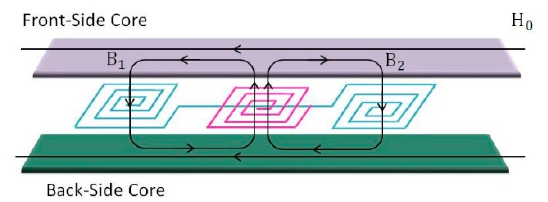
Figure 1. Shape of output in time and frequency domain for a sensor sample.